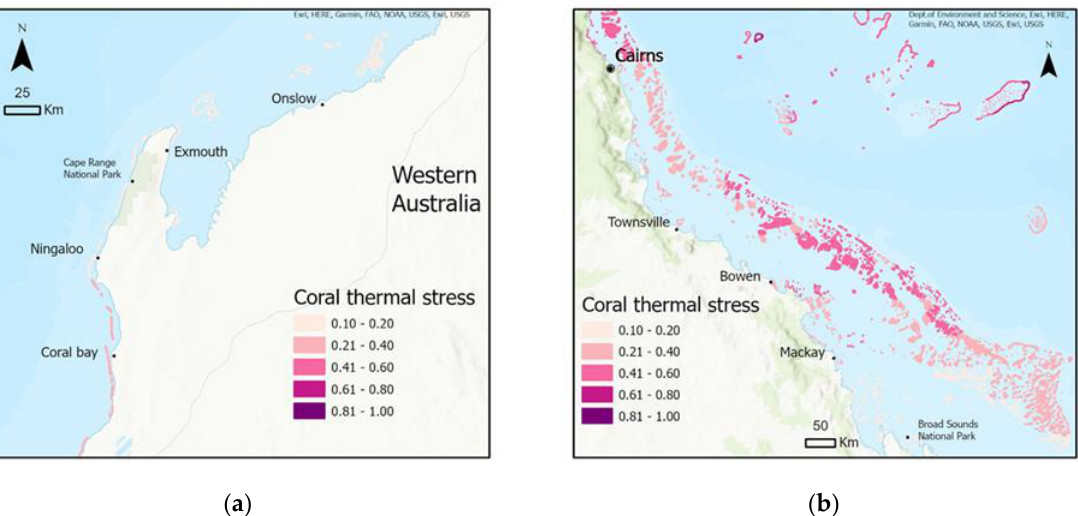
Figure 9. Vulnerability indicator maps of coral thermal stress in the Ningaloo Reef ( a ) and the southern Great Barrier Reef ( b ). Higher (darker) values denote greater thermal stress to corals.